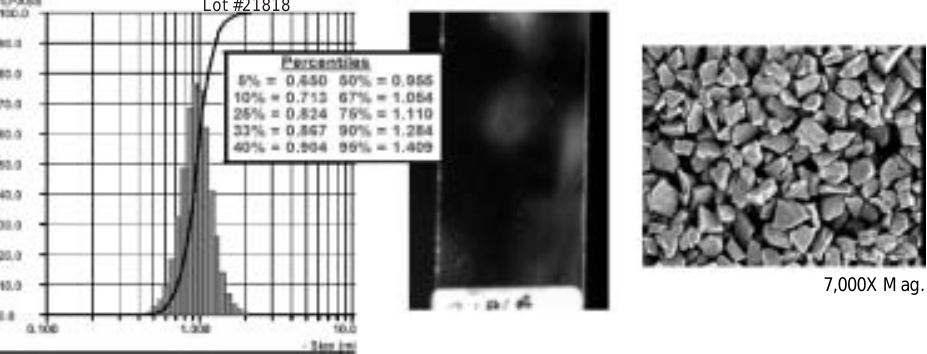
B.) Diamond powder with similar bulk size distribution as A, but with no oversize